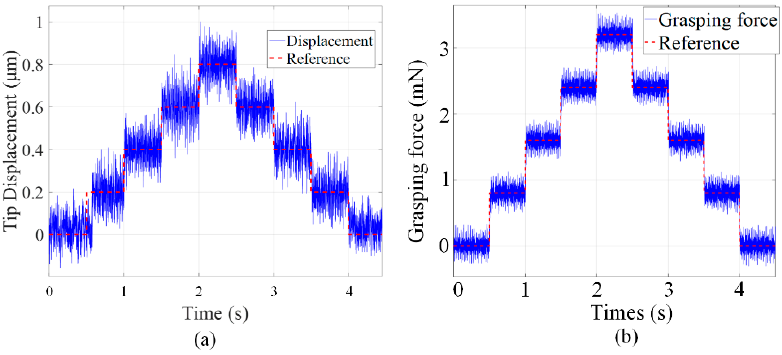
Figure 10. ( a ) The motion resolution and ( b ) the grasping force resolution, of the